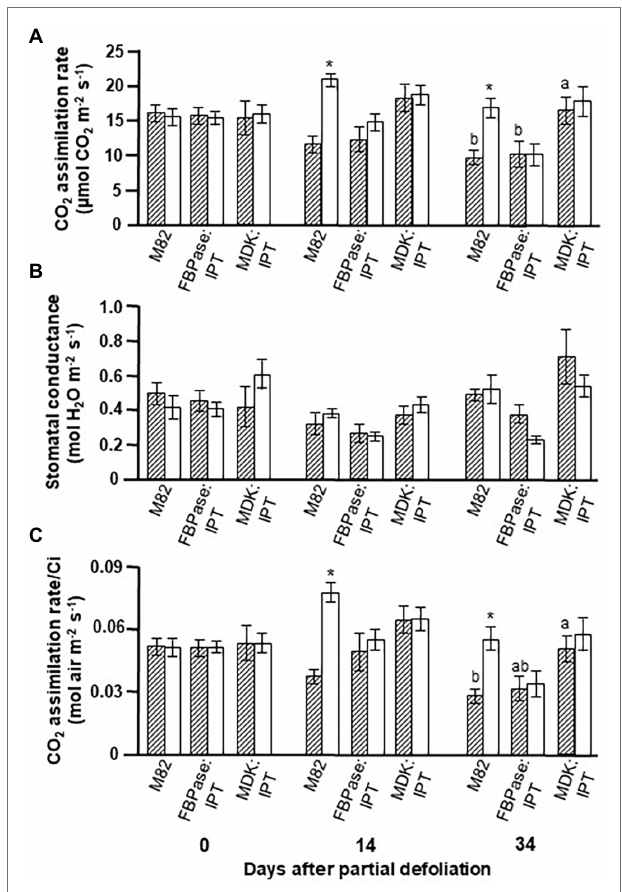
FIGURE 1 | Effect of enhanced cytokinin biosynthesis on the photosynthetic activity response to partial defoliation. Photosynthetic rate (A) , stomatal conductance (B) , and rate of photosynthesis per internal CO 2 concentration (Ci; C ) of source leaves in nondefoliated plants (hatched bars) and remaining tomato leaves after partial defoliation of the other leaves (empty bars). Defoliation was performed on mature plants at the reproductive stage of variety M82 and transgenic tomato plants expressing IPT under FBPase (FBPase:IPT, plant line #2) or AtMDK (MDK:IPT, plant line #5) promoters. Plants were grown in a temperature-controlled greenhouse (25 ° C/18 ° C day/ night). Data represent means (±SE) of six biological replicates. Different letters indicate significant differences between the tomato lines on a specific date ( p < 0.05) by Tukey HSD test. Asterisks indicate significant differences between partially defoliated and nondefoliated same tomato line at p < 0.05 by Student’s t